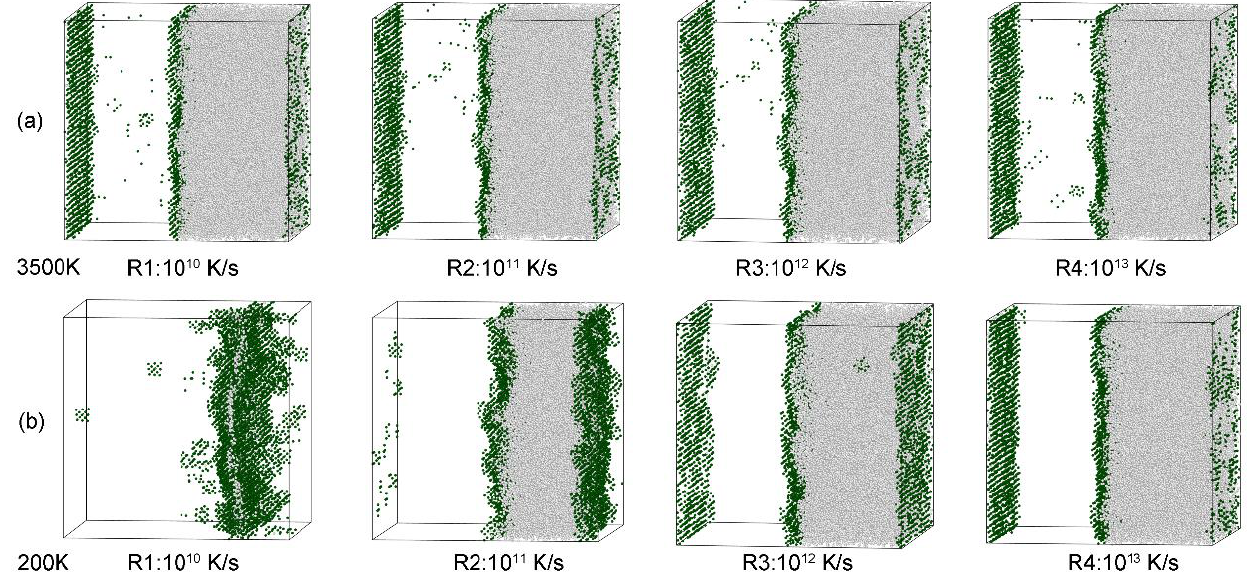
Figure 7. Evolution of the shape and location of the solid–liquid interface and defect distribution at different cooling rates. The green and gray spheres represent the first neighbor atoms of the zinc-blende crystal structure and the liquid structure,